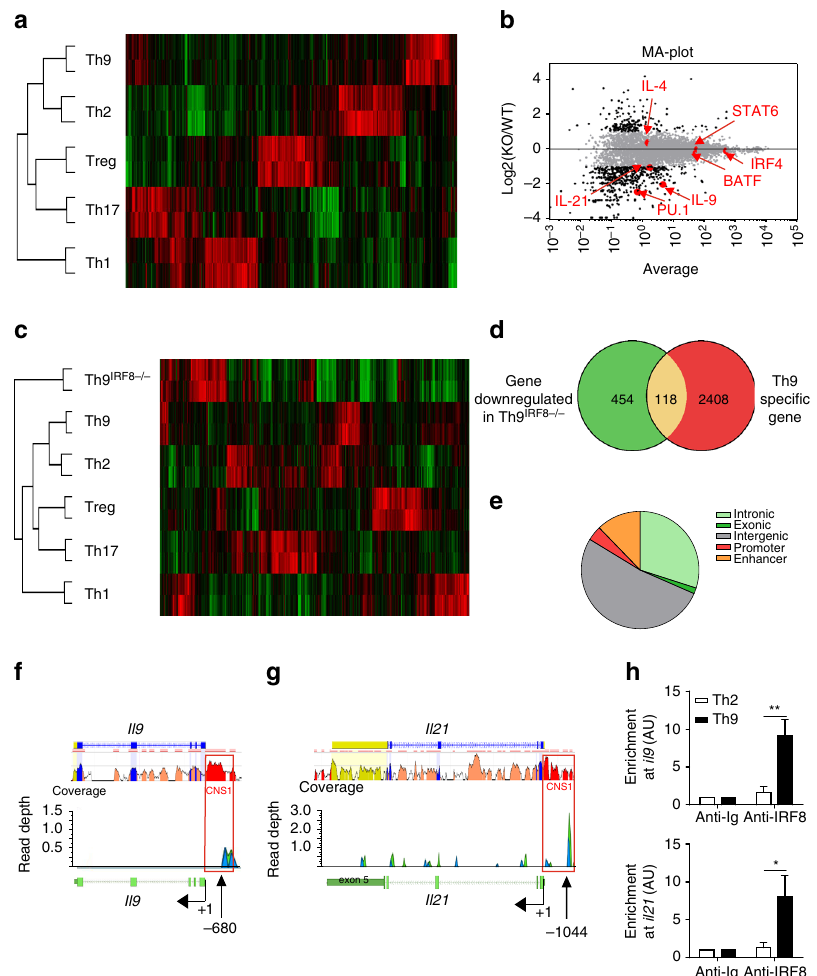
Fig. 3 IRF8 is required for Th9 transcription program setting-up. a Heat map showing RNA sequencing data of WT Th1, Th2, Th9, Treg and Th17 cells differentiated for 24 h. b MA-plot showing RNA sequencing data of WT or IRF8 − / − Th9 cells after 24 h of differentiation. Genes upregulated or downregulated by at least 2-fold in IRF8 − / − Th9 cells compared with WT Th9 cells are labelled in black, genes with similar expression in both IRF8 − / − and WT Th9 cells are labelled in grey. Th9 cells-speci fi c cytokines ( Il9 and Il21 ) and genes of interest ( Il4, Sfpi1, Batf, Irf4, Stat6 ) are highlighted in red. c Heat map showing RNA sequencing data of WT Th1, Th2, Th9, Treg, Th17 and Th9 IRF8 − / − cells differentiated for 24 h. d Venn diagram of genes downregulated in IRF8 − / − Th9 cells at 24 h (green) and Th9 cells-speci fi c genes (red). e Distribution of IRF8 ChIP sequencing peaks in WT Th9 cells. f , g Top panel presents a screenshot from the ECR (evolutionary conserved regions) Browser web site of the mouse Il9 ( f ) and Il21 ( g ) genes. Exonic regions are in blue, intronic regions in pink, UTRs in yellow and CNS are in red. Bottom panel presents IRF8-binding peaks in WT Th9 cells at Il9 ( f ) and Il21 ( g ) loci. h ChIP analysis of the interaction between IRF8 and the CNS1 of Il9 or Il21 promoter in Th2 and Th9 cells. ns, not signi fi cant; * P < 0.05, ** P < 0.01; *** P < 0.001 (two-way ANOVA ( h )). Data are from four h independent experiments (mean and